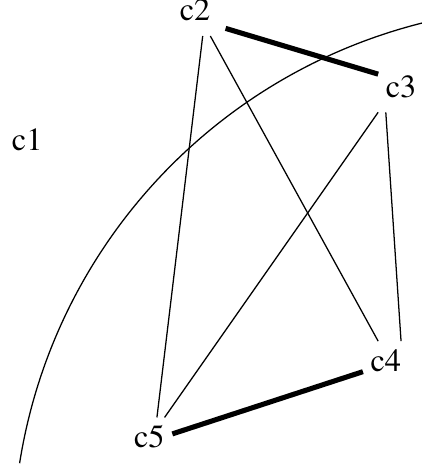
Figure 2. Representation of Step 3.1.2 in the Algorithm for Measure determination. We use c j + 1 = { c 5 , c 4 , c 3 } and we add the element e = c 2 . Using d ( A , c j ) = min c d ( { c 5 , c 4 , c 3 } , c 2 ) =